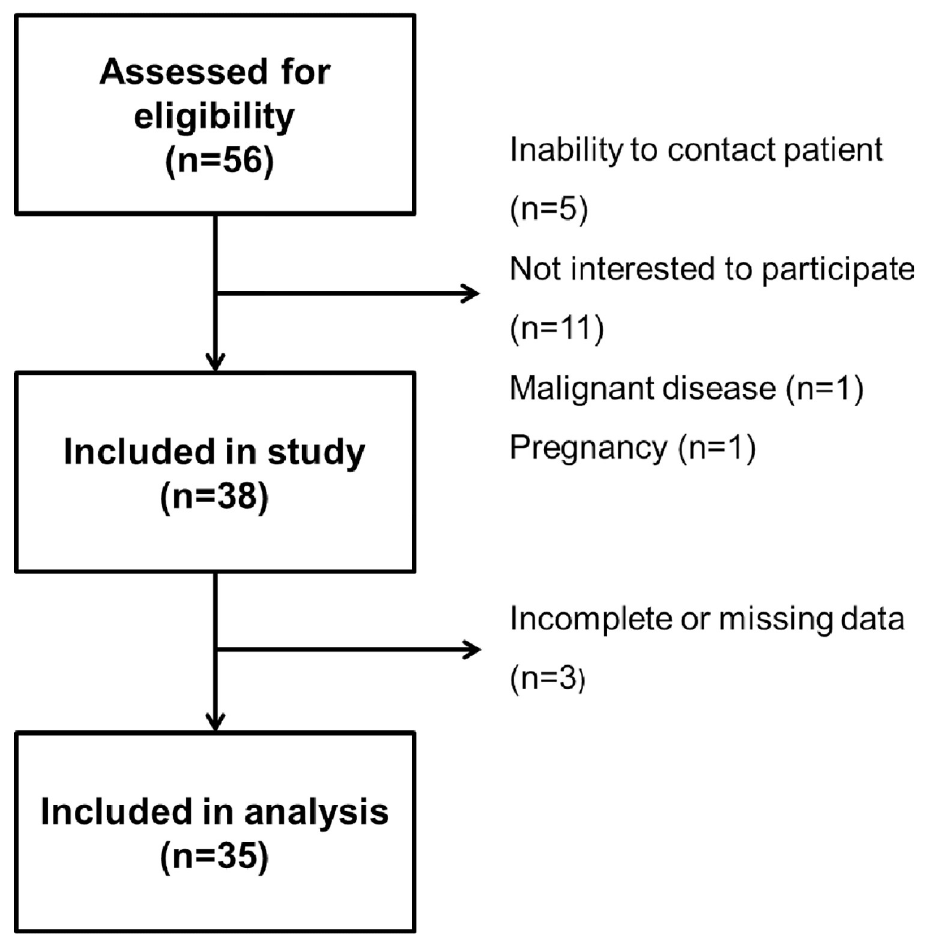
Fig 1. Flowchart illustrating the process of